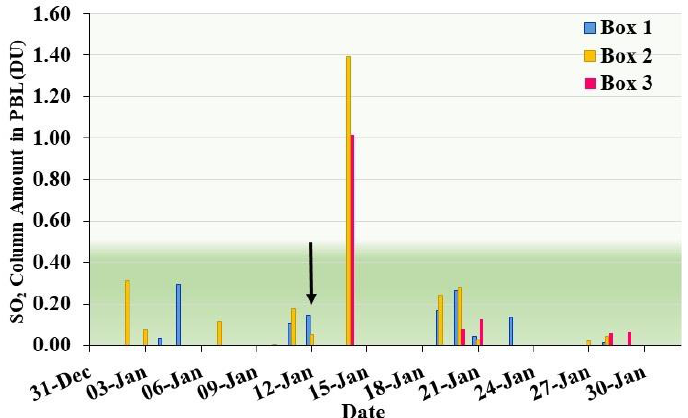
Figure 8. Temporal variations of Total Column SO 2 over Boxes 1 – 3 using OMI measurements. A sharp rise in SO 2 is observed over Boxes 2 and 3 on 14 January, and the volcanic eruptions started on 12 January 2020 (the black arrow points at the date of the volcanic eruption). The spatial distribution of enhanced SO 2 from Sentinel-5P TROPOMI is shown in Figure 9. The highest total vertical column of SO 2 appeared one day after the eruption and distributed along the northeast and the southwest. The strongest SO 2 emission (larger than 30 DU) on 13 January 2020 distributed over the Philippine Sea, northeast of the Taal volcano , which coincided with the forward trajectory of airmass at a higher altitude (Figure 4-ii, iii) showing the sensitivity to the upper troposphere. Also, the obvious enhancement in SO 2 appeared in the surrounding region of the southwest of Taal. On 14 January, the enhanced SO 2 moved to the south-west and distributed over the ocean, with a lower value (less than 20 DU) compared to the preceding day. Enhanced SO 2 disappeared on 15 January 2020, from the Taal volcano, emissions of gases were intermittent, not continuous, which is supported from the variability in SO 2 concentrations. The earthquake occurrences were frequent on 12 and 13 January 2020, and afterward, few earthquakes occurred. The observed earthquakes were induced from volcanic eruptions, so obviously frequent earthquakes were observed on 12 and 13 January 2020, and afterward, the volcanic eruption was stopped. This observation clearly supports the observed low emissions of SO 2 after two days of eruptions. Figure 9. Spatial distribution of the total vertical column of TROPOspheric Monitoring Instrument (TROPOMI) SO 2 after the eruption of the Taal volcano observed by Sentinel-5P. The red triangle indicates the geographic location of the Taal volcano.